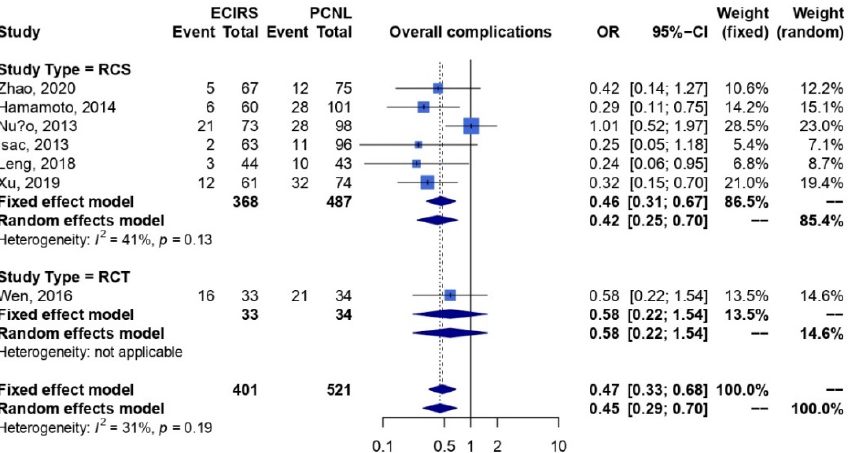
Figure A12. Subgroup analysis of outcome regarding overall complications. (RCS: [18-23]; RCT: [17]).